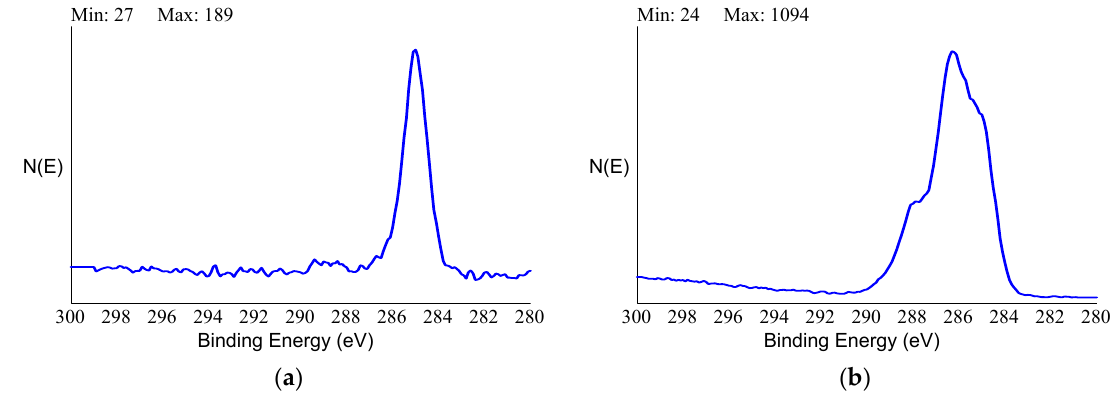
Figure 6. XPS high-resolution C1s peak of control ( a ) and HY-coated ( b ) titanium implant.